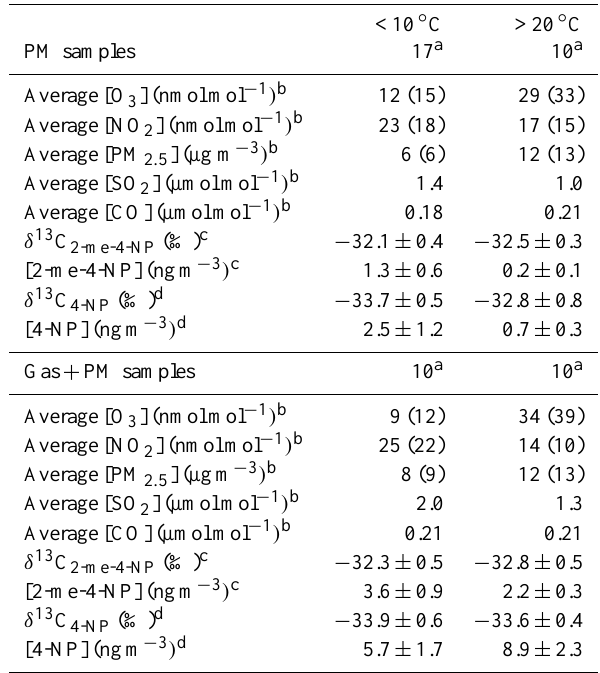
Figure 8. Gas + PM samples for the three methyl nitrophenols (a) and 4-nitrophenol (b) were binned according to isotope ratio and separated by the given temperature ranges. The left column in each bin has winds originating from the north and the right column in each bin has winds originating from the southwest. Wind direc- tion was based on HYSPLIT (Hybrid Single Particle Lagrangian Integrated Trajectory Model by Air Resources Laboratory, NOAA) trajectory